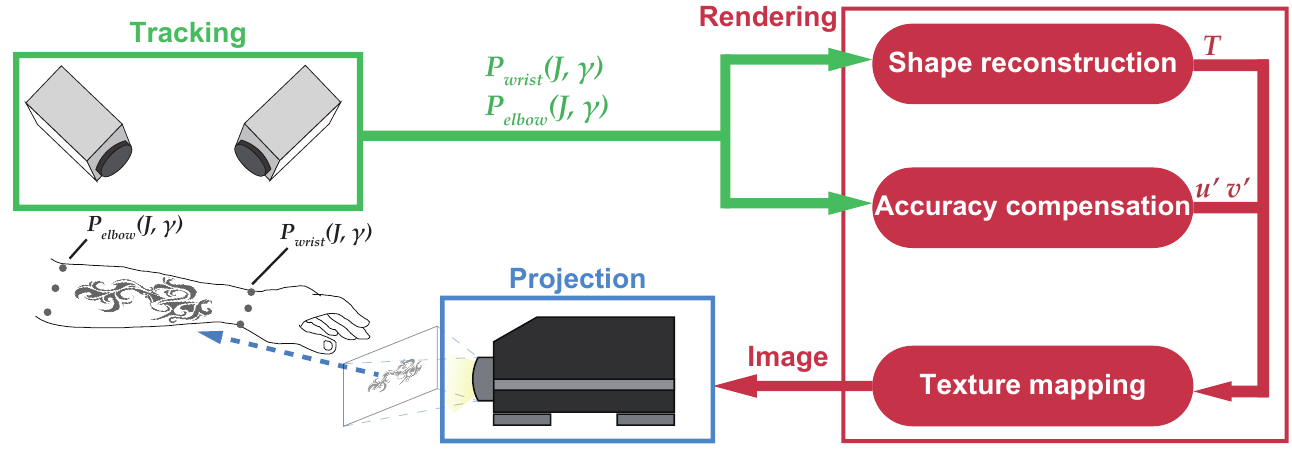
Figure 1. System configuration and method